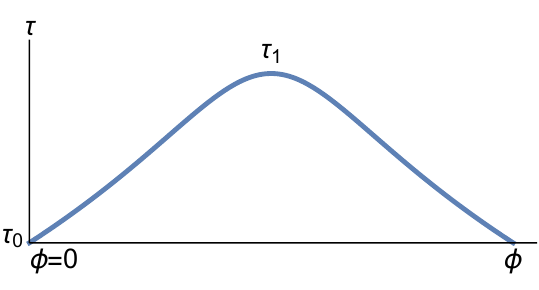
Figure 3 . HRT extremal surface for an interval of size (cid:30) at a general time (cid:28) 0